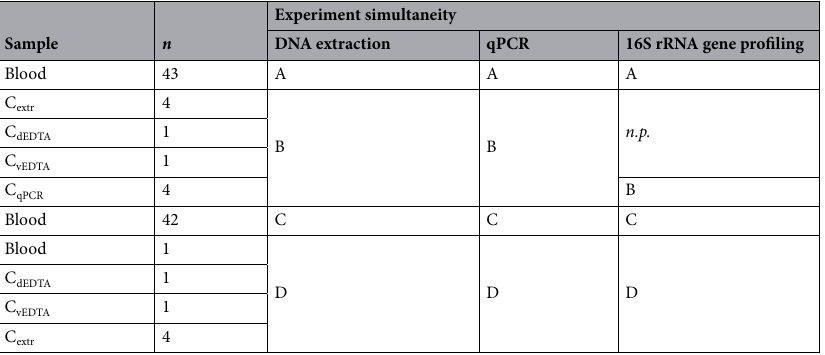
Table 2. List of samples analyzed in the study and simultaneity of the experimental steps. Samples with the same letter (A, B, C or D) have been concurrently processed. C extr , ultrapure water; C dEDTA , commercial phosphate buffered saline (PBS) added directly into an EDTA tube; C vEDTA , PBS added into an EDTA tube after passage through a vacutainer blood collection system; n , number of samples; n.p. , analysis not performed for the respective